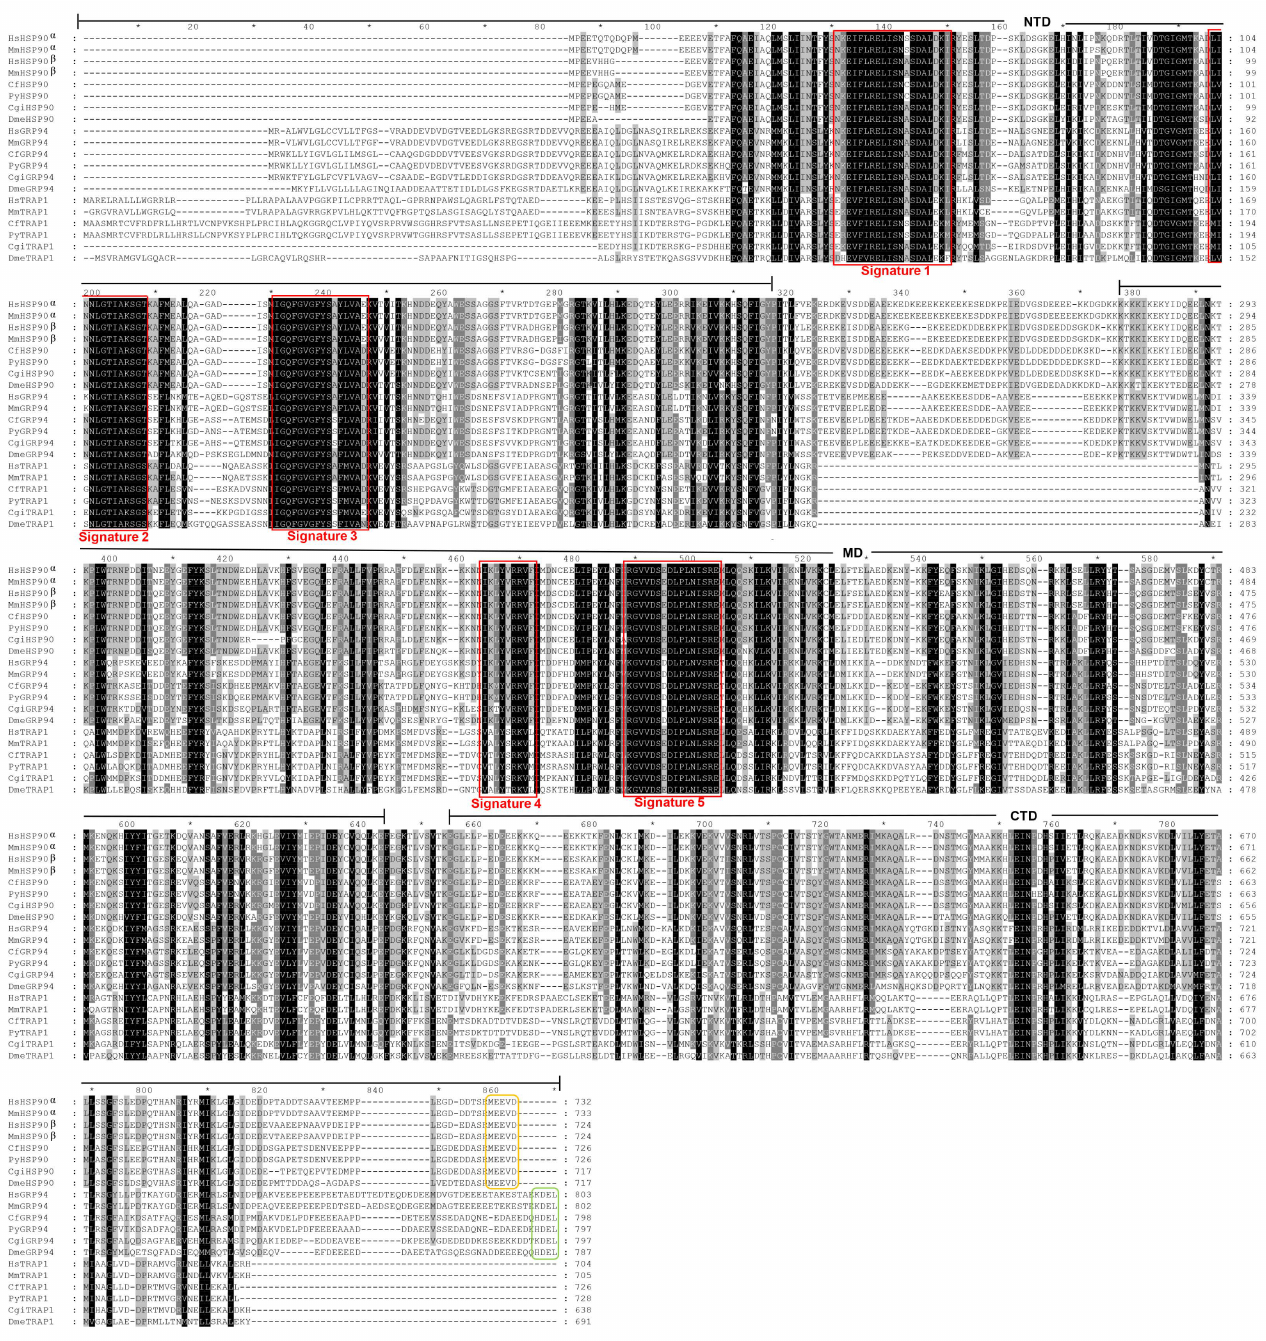
Figure 2. Multiple alignment of the amino acid sequences of HSP90s of Chlamys farreri with those of other species. Red box indicates HSP90 family signatures. The last five amino acids of HSP90 form the ‘MEEVD’ motif, which is marked with the orange box and the last four amino acids of GRP94 form the ‘H/KDEL’ motif which is marked with the green